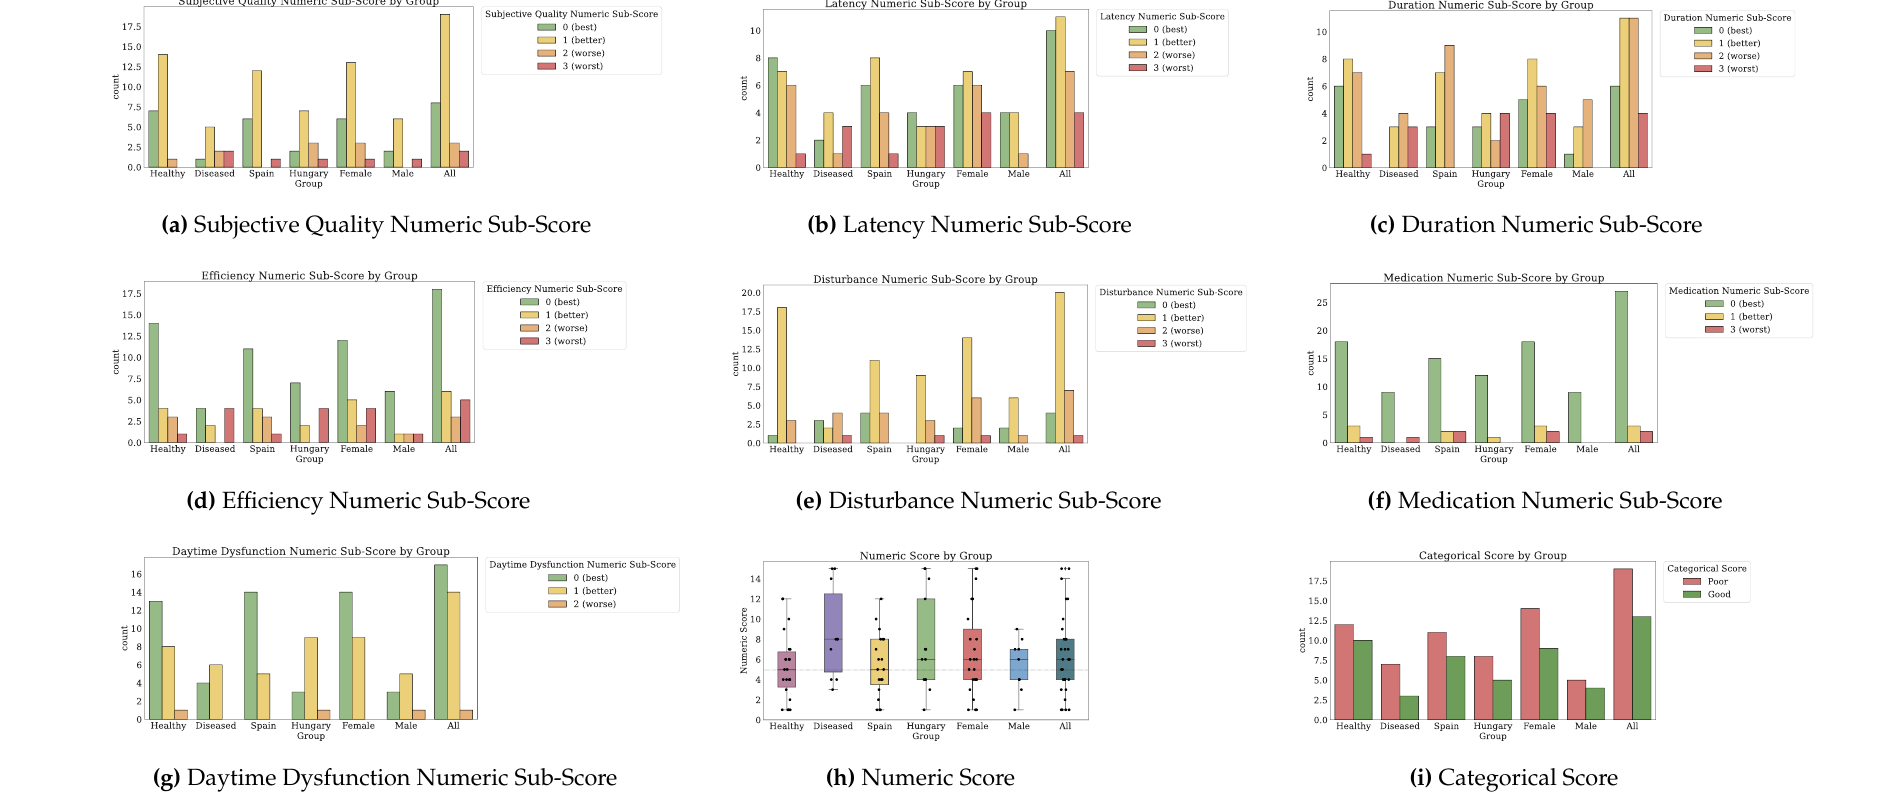
Figure A9. Sub-scores and Scores for Sleep (PSQI). Dotted markings delimit levels of the categorical score